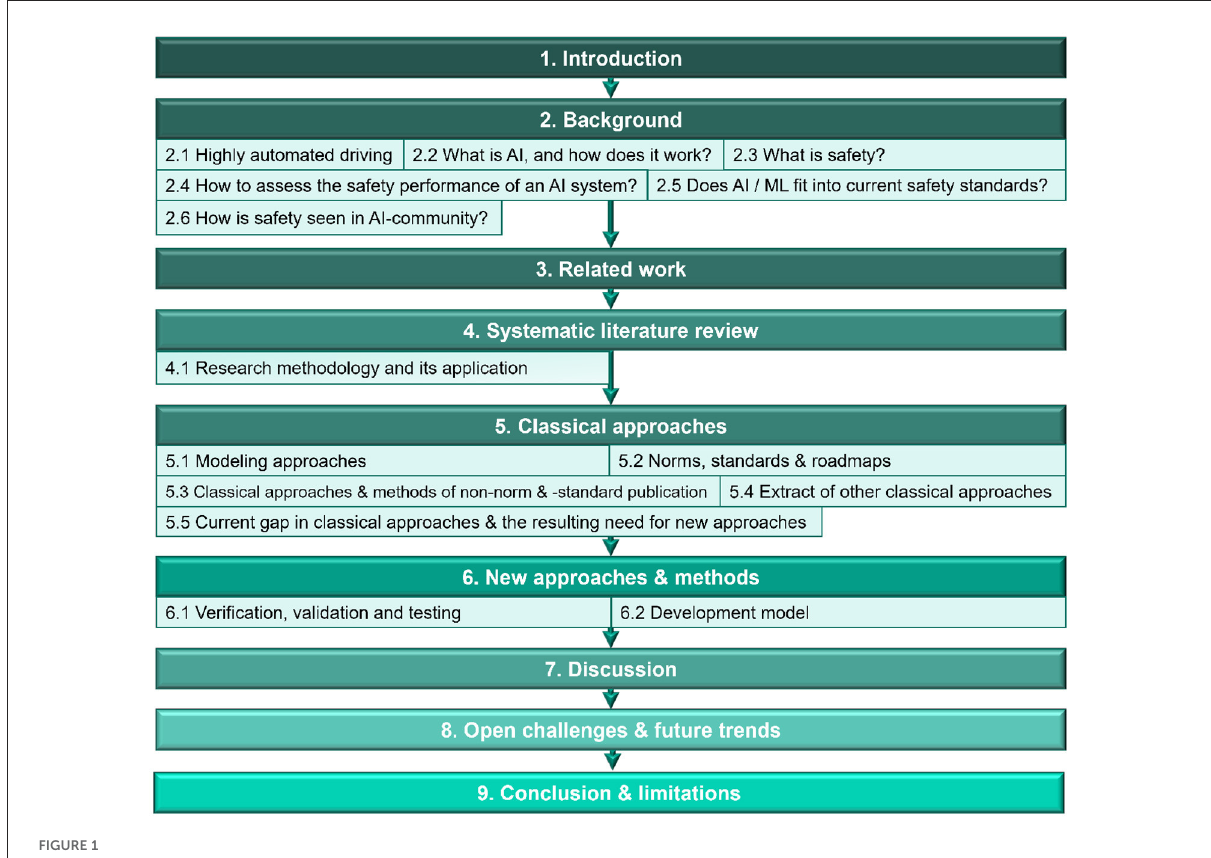
FIGURE1 Structure of the